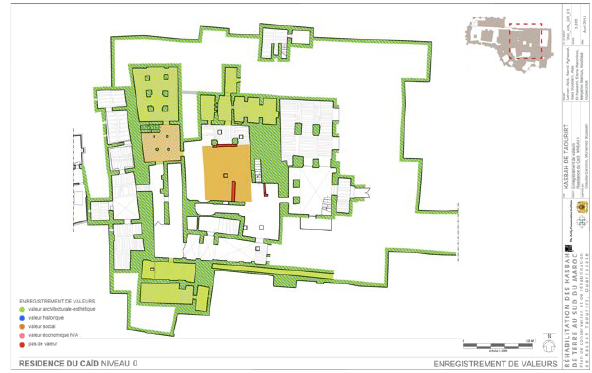
Figure 7: Values assessment of the Caïd Residence.